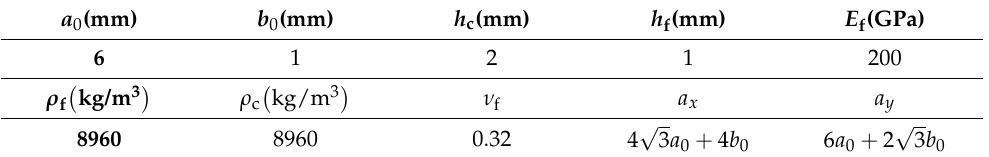
Table 1. Honeycomb sandwich panel parameters.